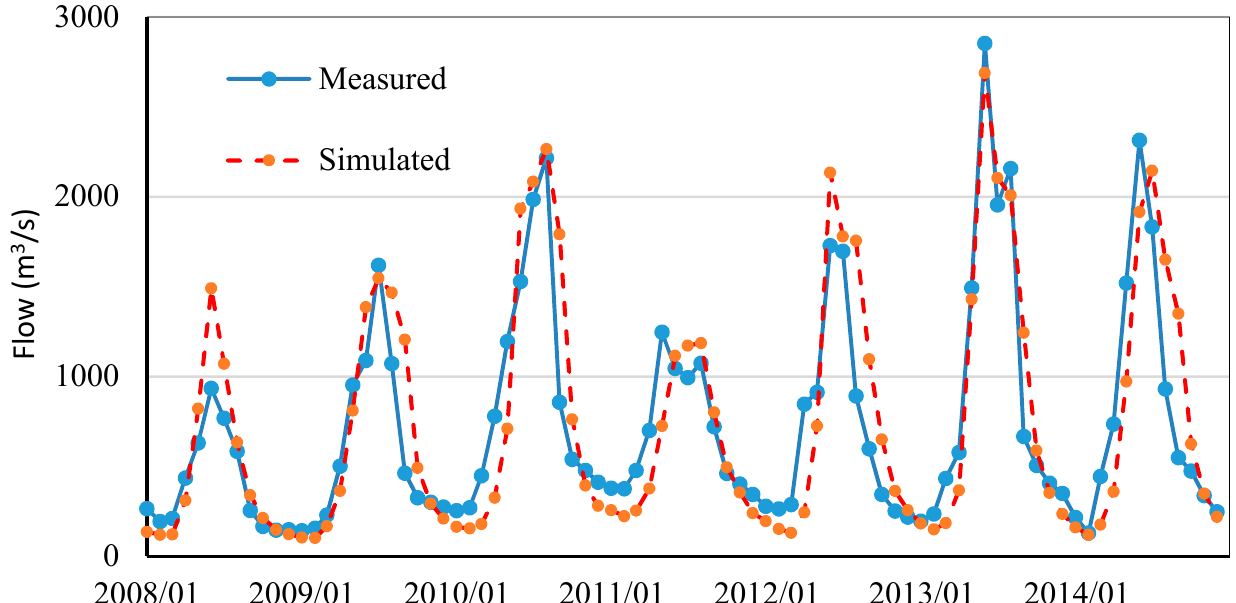
Figure 3. Measured and simulated monthly flow at the Dakah station from 2008 to 2014 (bias of 3.4%, NSE of 0.74, and R 2 of 0.80).